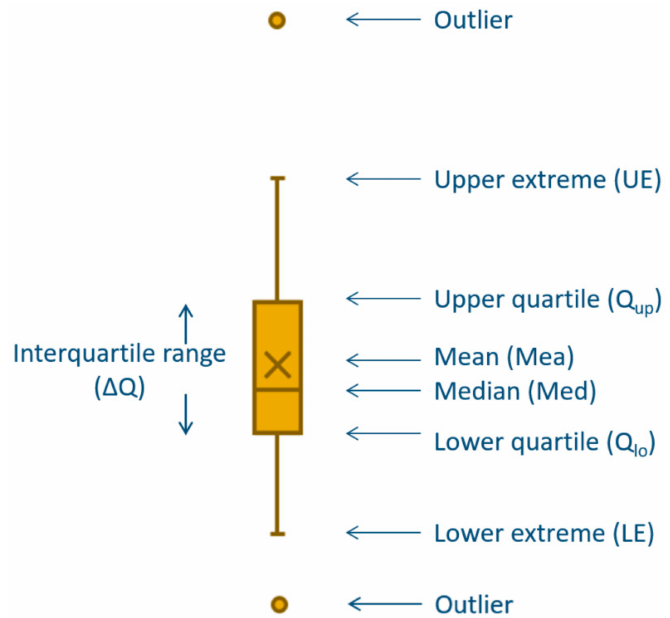
Figure 2. Configuration of box